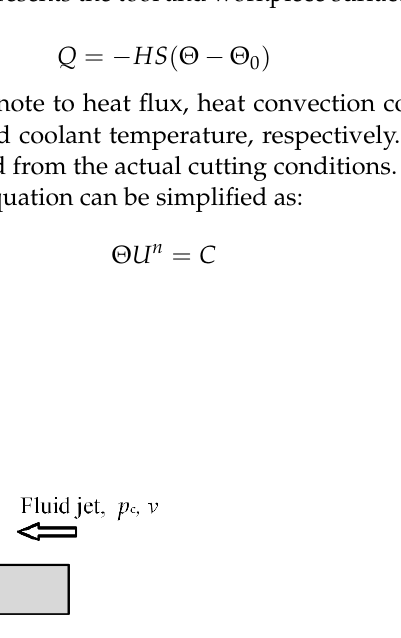
Figure 3. Schematics of the cooling process in the noncutting duration of HUVC. p c , cooling pressure, v , cooling speed, Q , heat.